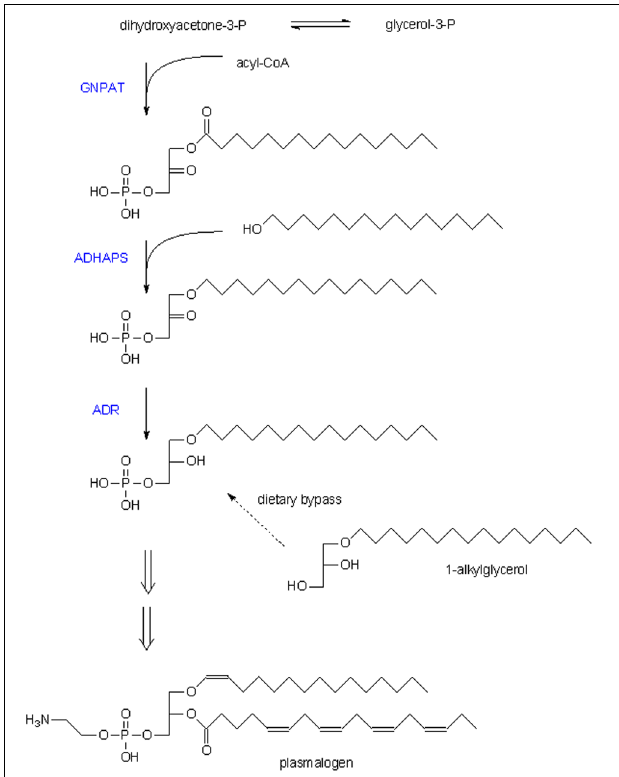
FIGURE 3 | Etherlipid biosynthesis. Scheme of the reactions involved in formation of ether lipids, starting with dihydroxyacetone-phosphate. The long chain alcohol used by ADHAPS it generally 16–18 carbons, either saturated or with one double bond. Double arrows indicate multiple steps, catalyzed by ER-associated enzymes like headgroup addition and the introduction of the double bond in the 1-alkylchain. Generally, plasmalogens are enriched in PUFA at position 2 of the glycerol moiety (shown is 1-hexadecyl-2-arachidonoyl-plasmenylethanolamine). Dietary 1-alkylglycerol can bypass the peroxisomal steps in this pathway (dashed arrow). GNPAT, dihydroxyacetone-phosphate acyltransferase; ADHAPS, alkyl dihydroxyacetone-phosphate synthase; ADR, acyl/alkyl-dihydroxyacetone- phosphate reductase.